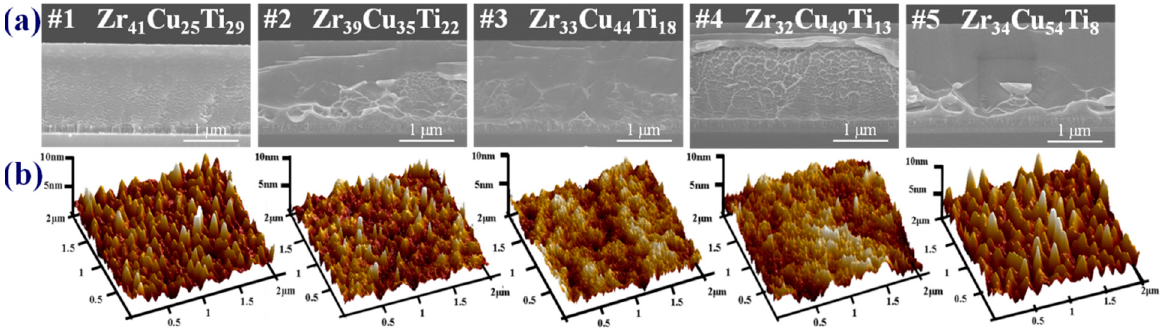
Figure 5. ( a ) Cross-sectional SEM and ( b ) three-dimensional topographical AFM images of Zr-Cu-Ti films of various compositions.